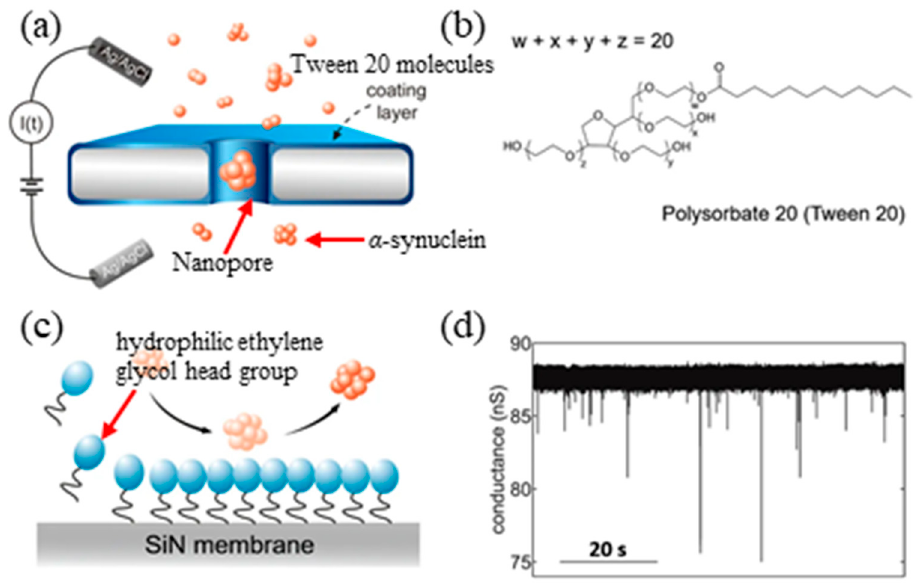
Figure 10. ( a ) Sketch of the experimental setup: the flow cell is separated by silicon nitride membrane with a nanopore. The silicon nitride membrane is coated by a layer of tween 20 molecules to mitigate non-specific binding; ( b ) the chemical structure of tween 20; ( c ) sketch showing the assemble process of tween 20 on hydrophobic silicon nitride membrane and the compact coating layer reduce irreversible non-specific adsorption of α -synuclein oligomers and ( d ) measured current traces of nanopore under 100 mV with α -synuclein sample incubated for 96 h at pH 9. Reproduced from reference [94] with permission from Springer Nature.